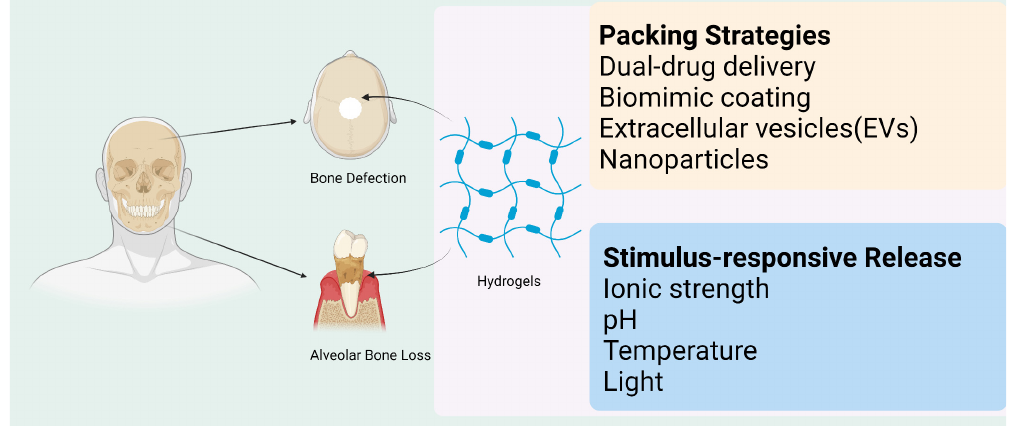
Figure 4. Hydrogels have been developed via different perspectives of bone repairing. Hydrogels pack different drugs and cells to serve as a scaffold in tissue engineering. The functional groups, forming part of the hydrogels, also contribute to drug loads. Responsive systems can also be applied in promoting the reconstruction of craniomaxillofacial bone defects. This image was drawn using BioRender , accessed on 1 December 2022 (https://biorender.com/).